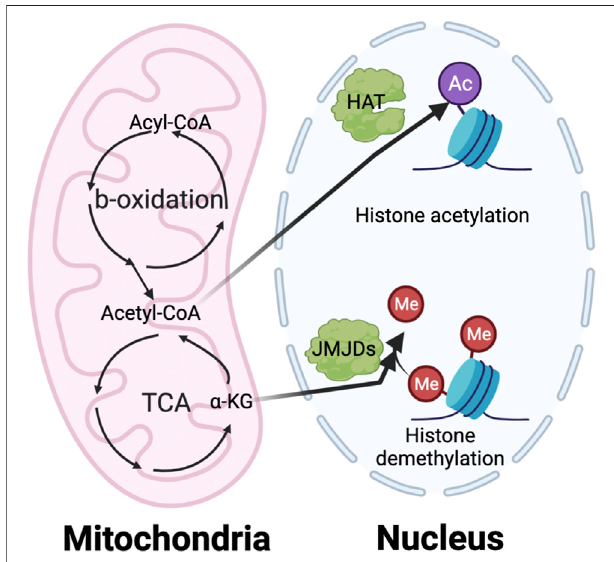
FIGURE 6 | The interaction of metabolism and epigenetics. The intermediatemetabolitesinmetabolicpathwayplayavitalroleinregulatingthe epigenetic modi fi cation, especially histone acetylation and methylation. The histone acetylation requires acetyl-CoA generated from TCA cycle in mitochondria as an essential substrate. On the other hand, the histone demethylation needs a-KG from TCA cycle as important cofactor of the Jumonji C domain-containing histone demethylases